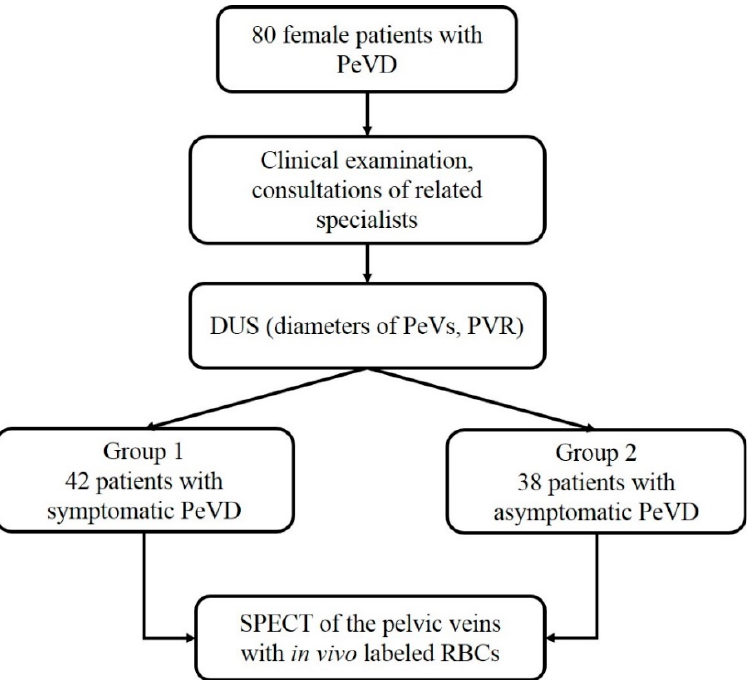
Figure 1. Study design. Abbreviations: PeVD, pelvic venous disorder; DUS, duplex ultrasonography; PeVs, pelvic veins; PVR, pelvic venous reflux; SPECT, single-photon emission computed tomography; RBCs, red blood cells.